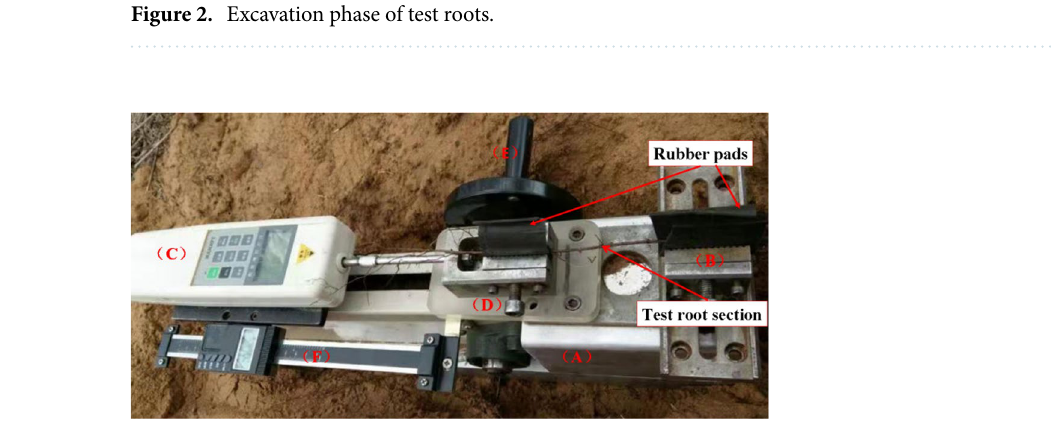
Figure 3. HG 100 digital display type push–pull meter and self-made portable test